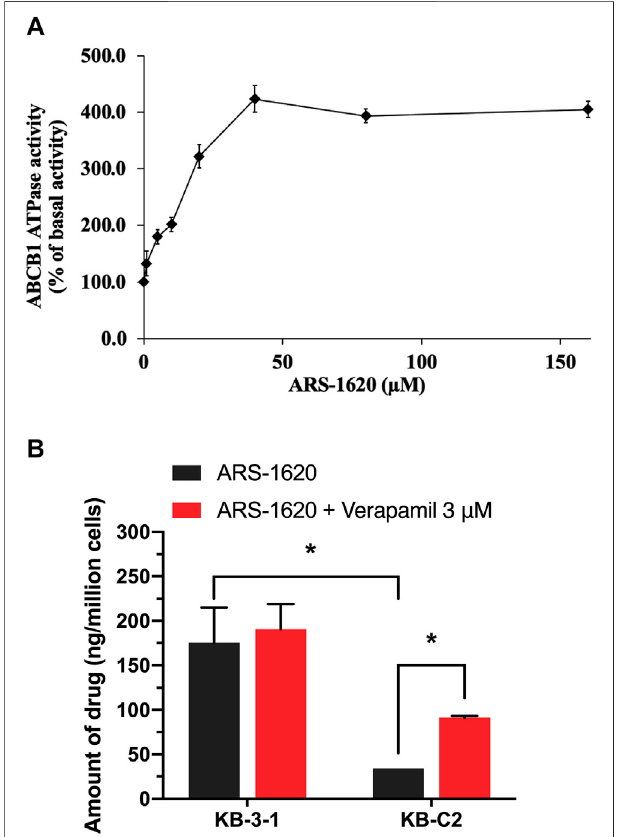
FIGURE 3 | The effect of ARS-1620 on the ATPase activity of ABCB1 andARS-1620gotactivelytransportedoutbyABCB1-overexpressingcancer cells. (A) ARS-1620 (0 – 160 μ M) stimulates ABCB1 ATPase activity. (B) The intracellularaccumulation ofARS-1620inKB-3-1andKB-C2 cells.Data are displayed as mean ± SD of three independent assays. * p <